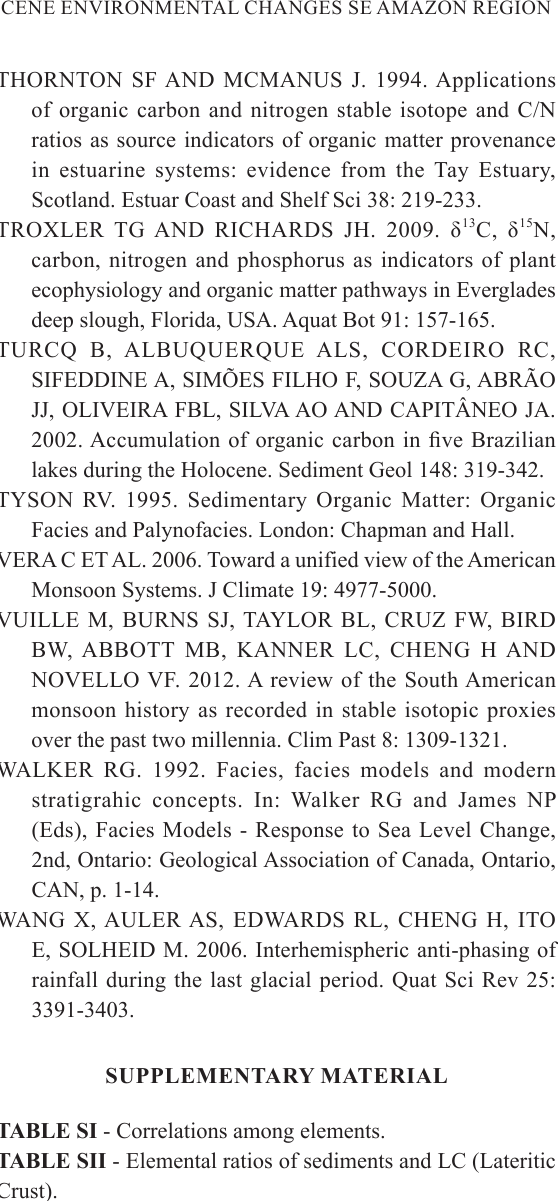
TABLE SI - Correlations among elements. TABLE SII - Elemental ratios of sediments and LC (Lateritic